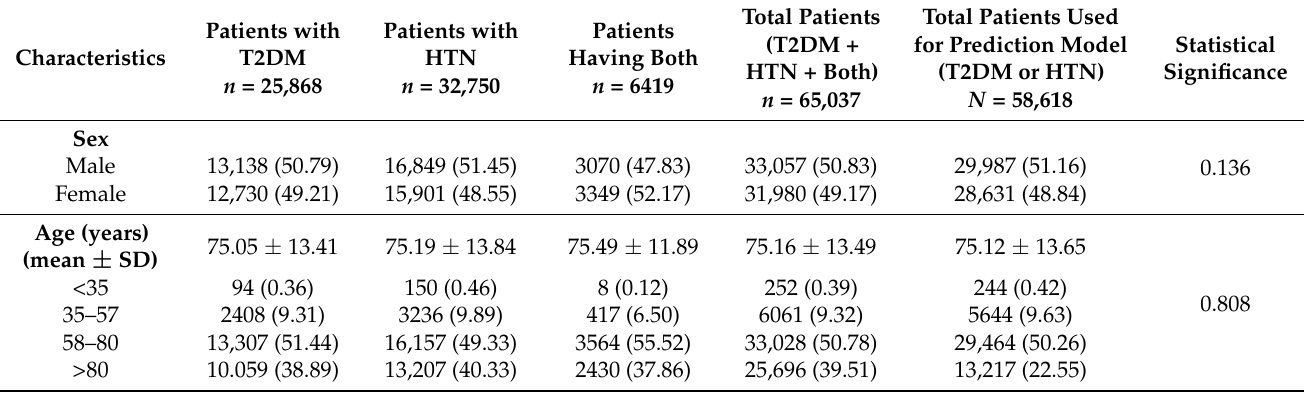
Table 1. Demographic characteristics of the